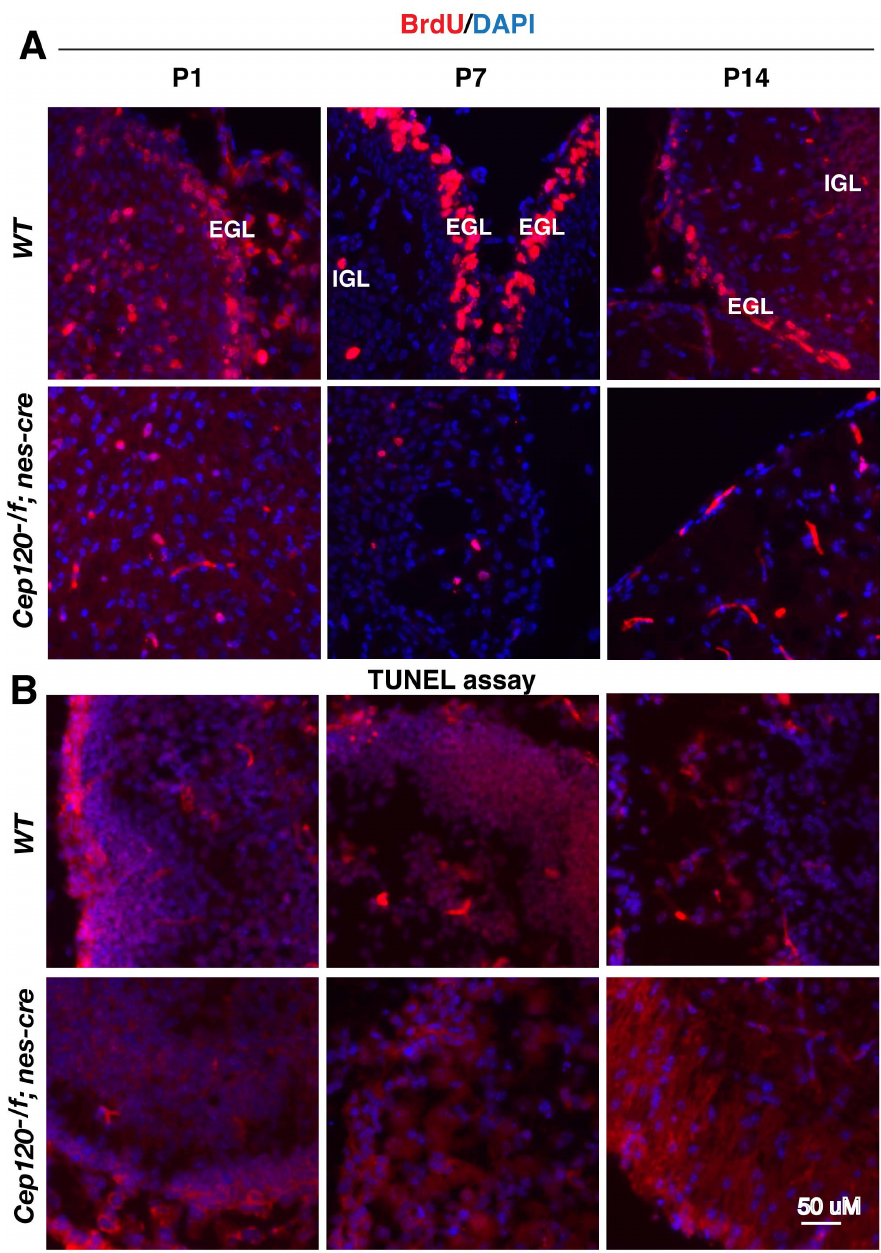
Figure 6. Failed proliferation of granule neuron progenitors (GNPs) in the Cep120 mutant cerebellum. (A) BrdU labeling showed BrdU incorporated into a significant number of GNPs in the wild type cerebellum (upper panels), but not in the Cep120 mutant (lower panels). (B) A TUNEL assay showed that no significant number of cells in Cep120 mutant cerebellum had undergone apoptosis. Representative areas of the cerebellum are shown. Nuclei are stained with DAPI (blue). EGL, external granule layer; and IGL, inner granule layer.